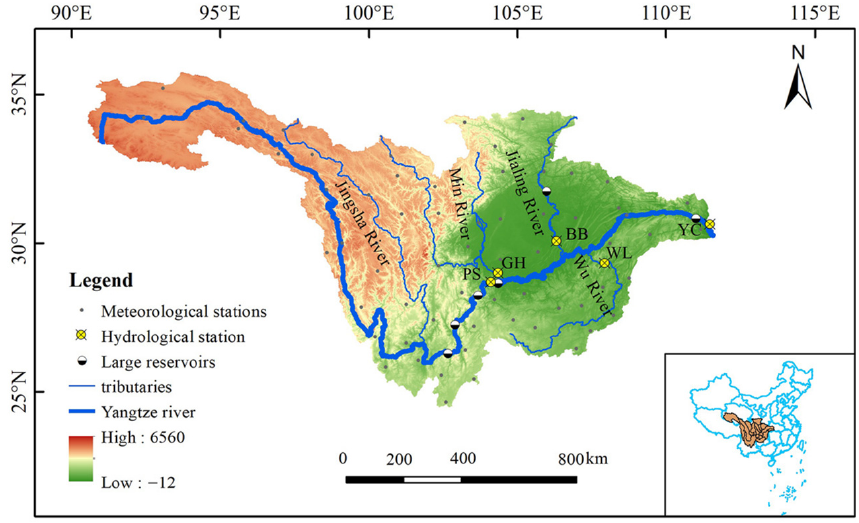
Figure 1. Map of the upper Yangtze River basin area.